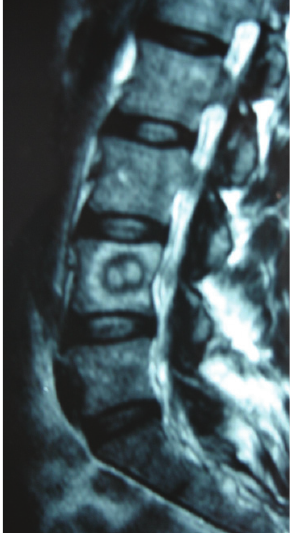
Figure 5 - Magnetic resonance showing a sagittal section through the lumbar column in a T2 sequence, demonstrating the tumor niche and the sclerosis halo.